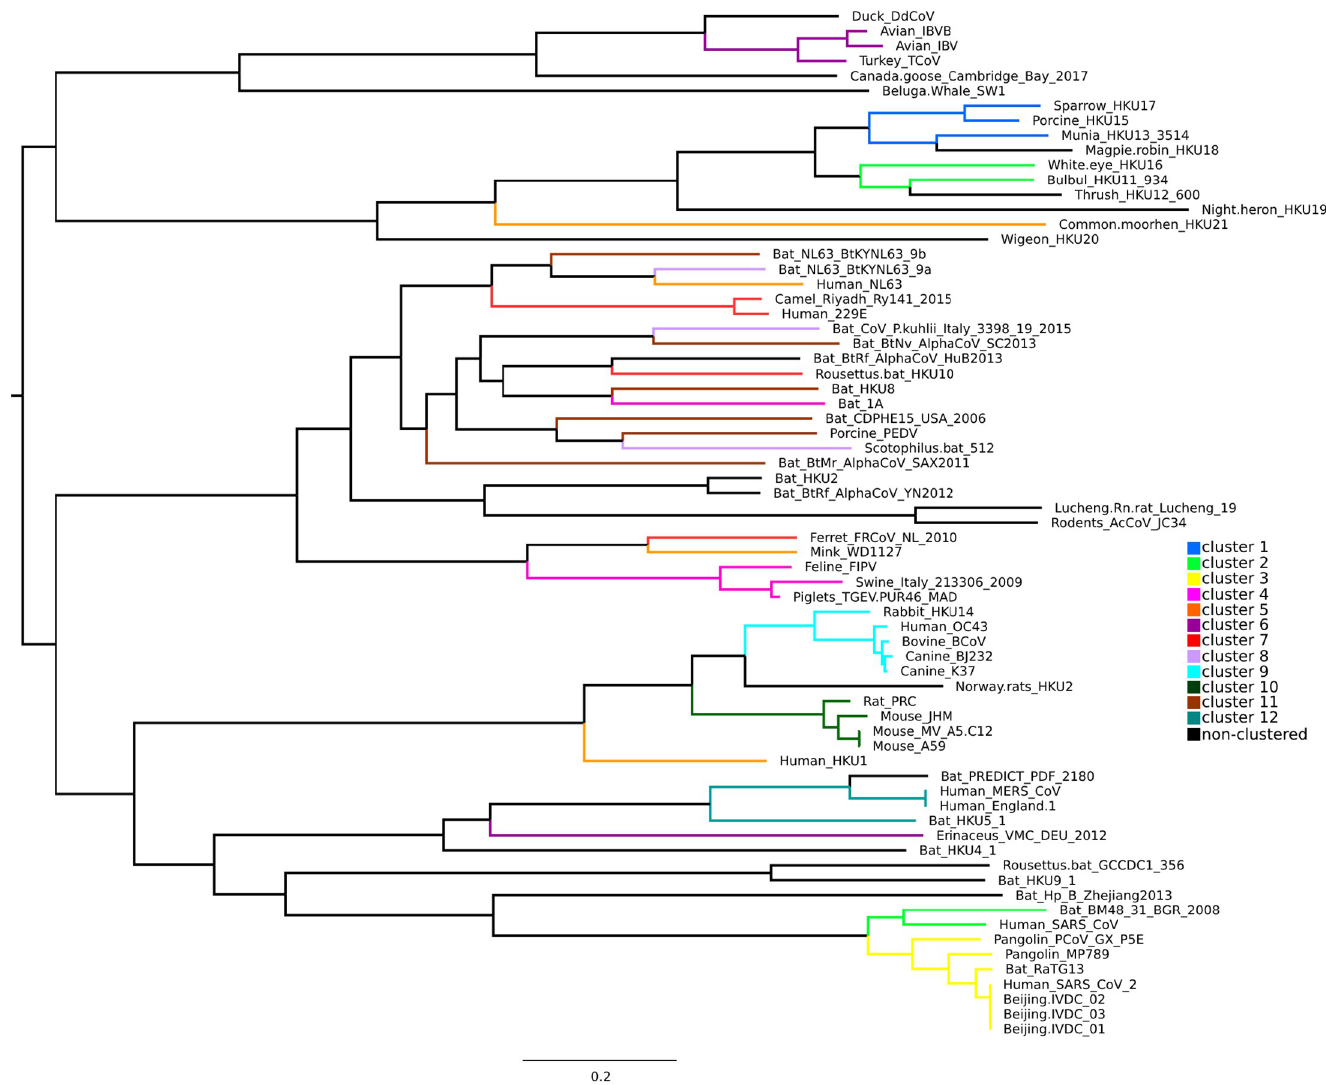
Fig 7. Phylogenetic tree based on whole genome alignment of 69 genomes of coronaviruses (see also Fig 1). Branches of the tree are colored according to the same colors, which were used to color the clusters on the elastic map in Fig 4 and presented in the figure legend also here. Black color depicts genomes that were not included in any cluster on the elastic